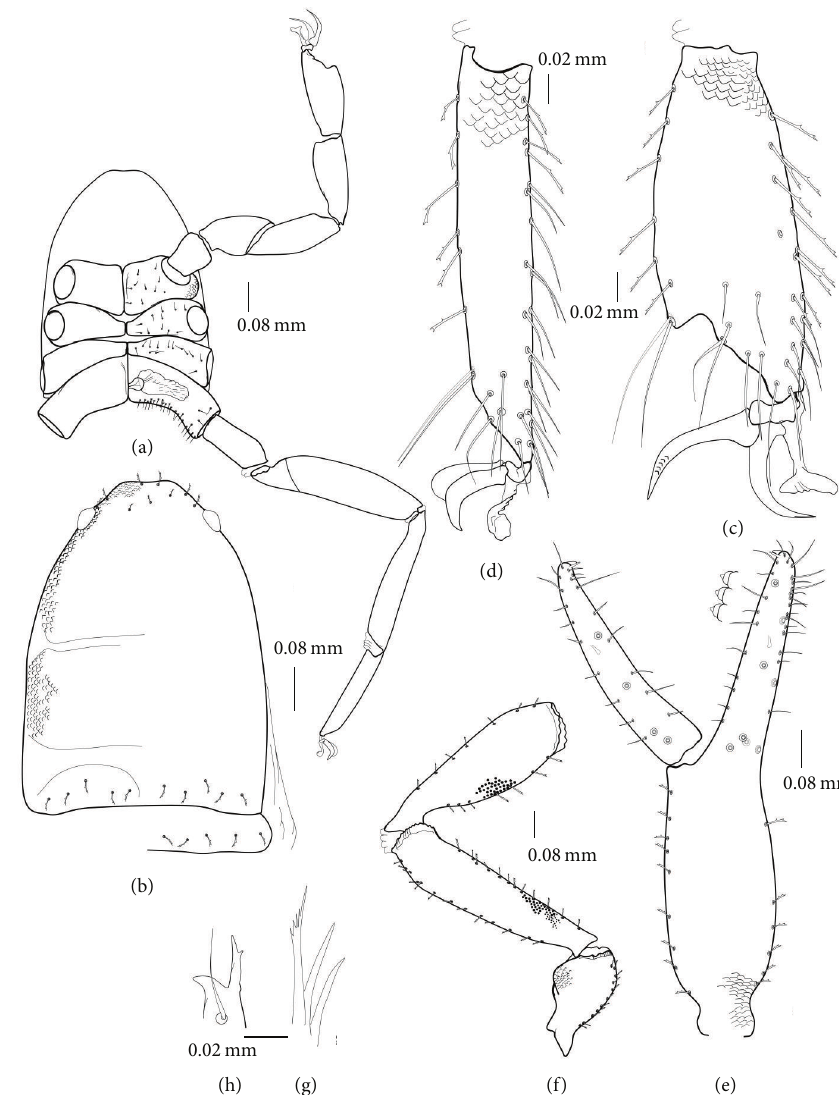
Figure 7: Male: (a) legs and ventral side of carapace, (b) dorsal side of carapace, (c) tarsus of leg I, (d) tarsus of leg IV, (e) left chela, (f) pedipalp, (g) rallum, and (h)